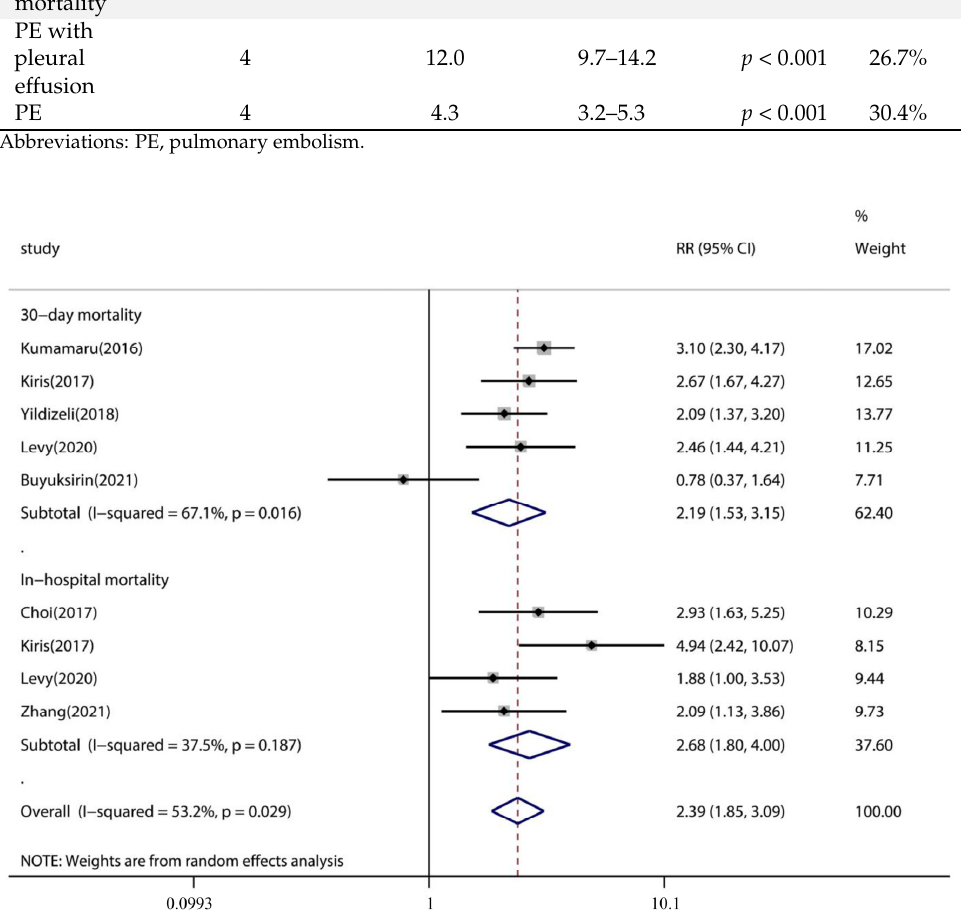
Figure 3. Descriptive forest plot of the effect of pleural effusion on PE 30-day mortality and in-hos- pital mortality outcomes. CI, confidence interval; PE, pulmonary embolism. mortality outcomes. CI, confidence interval; PE, pulmonary